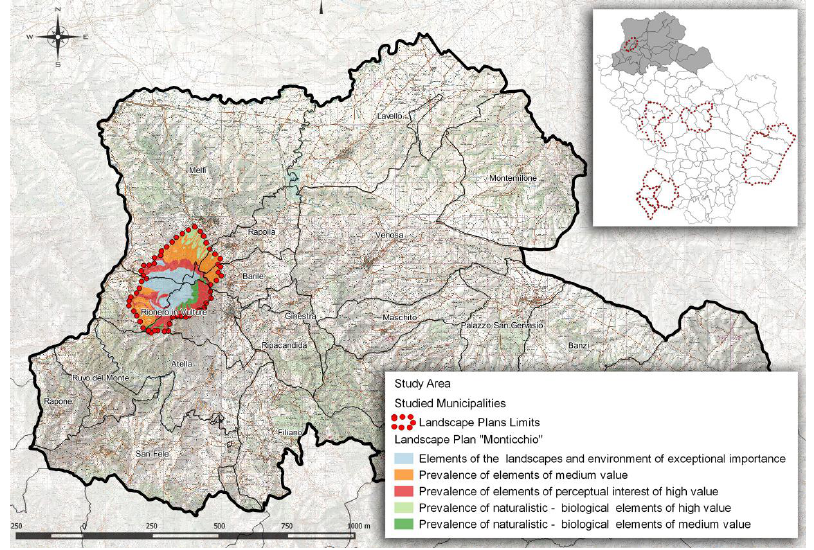
Figure 12. Landscape plan of “Monticchio”.